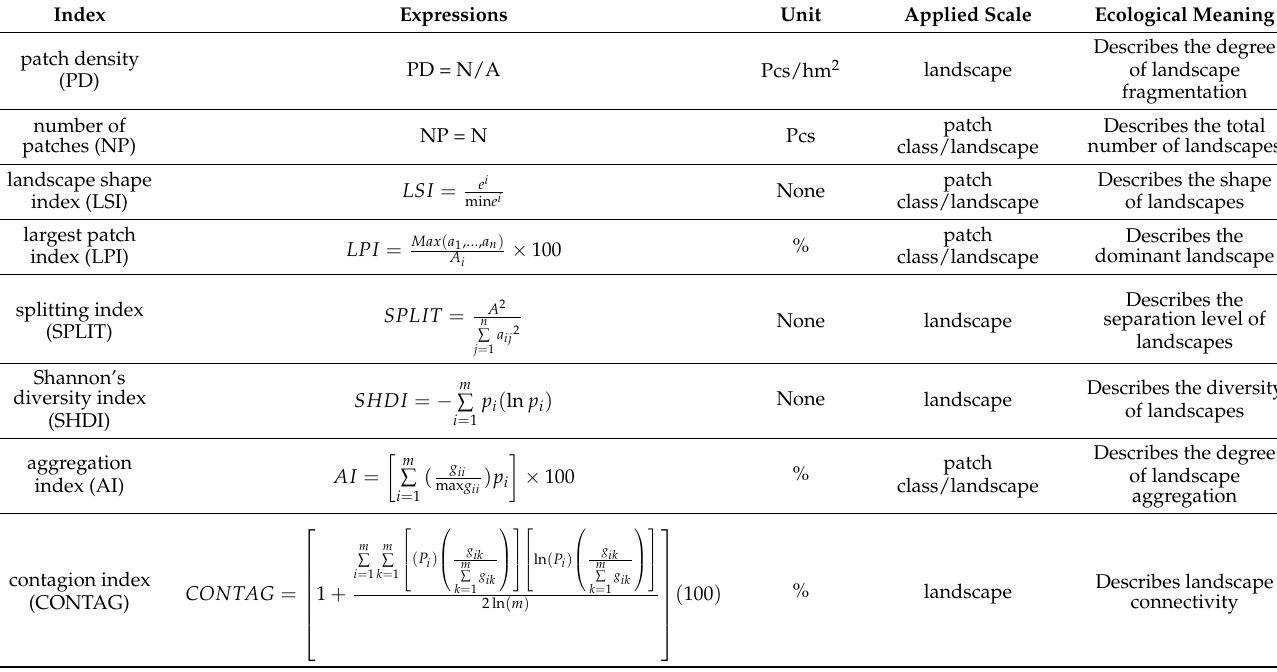
Table 1. Landscape indices formula and ecological